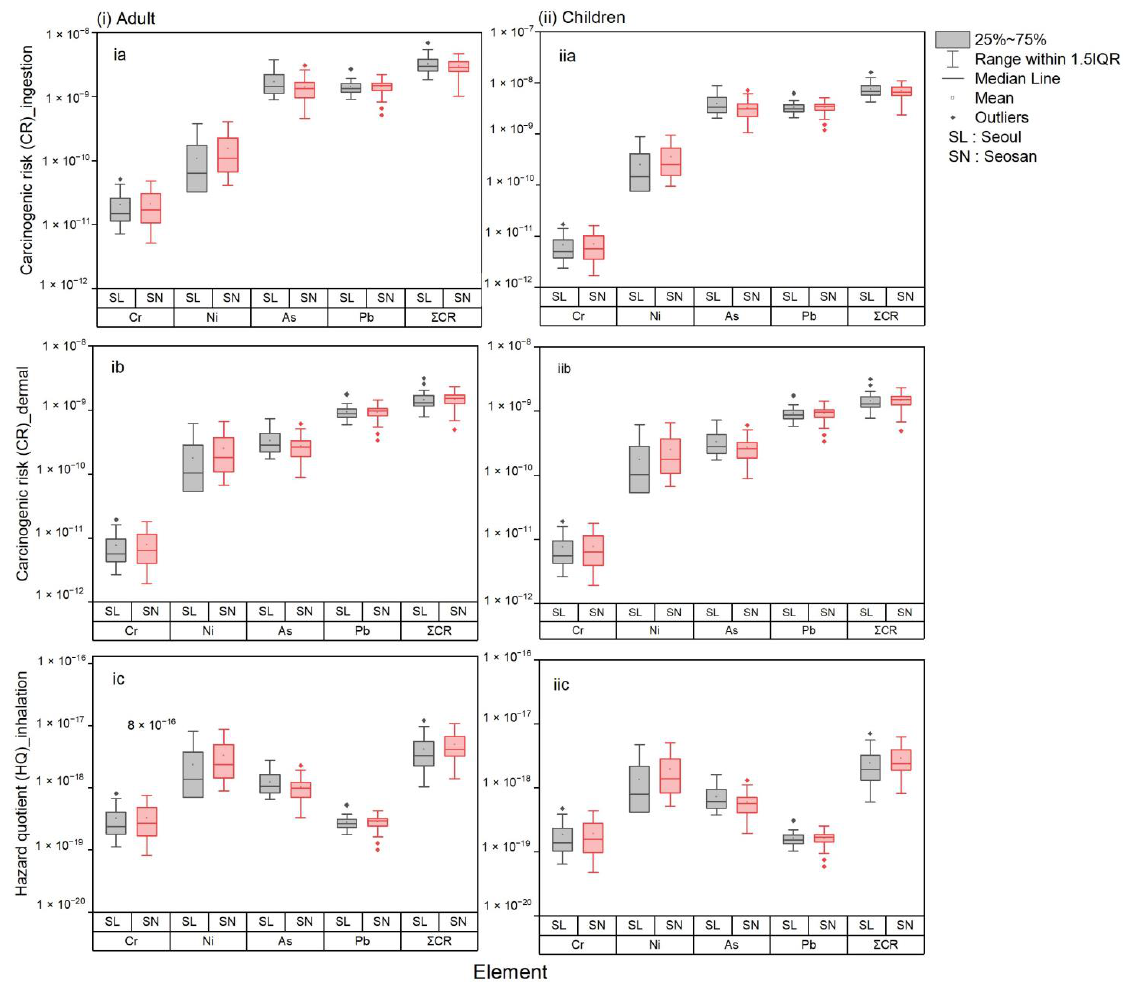
Figure 4. Cancer risk (CR) associated with elements in PM 2.5 in Seoul and Seosan during the winter of 2020 – 2021.